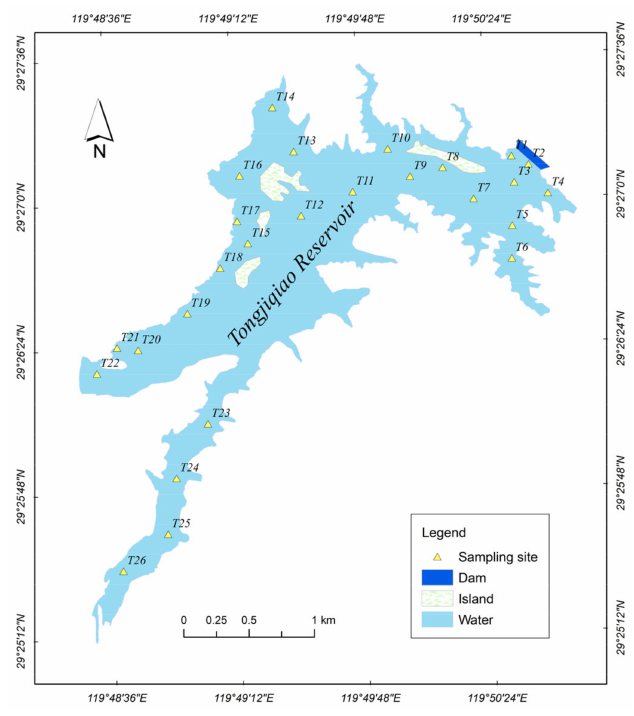
Figure 1. Sampling